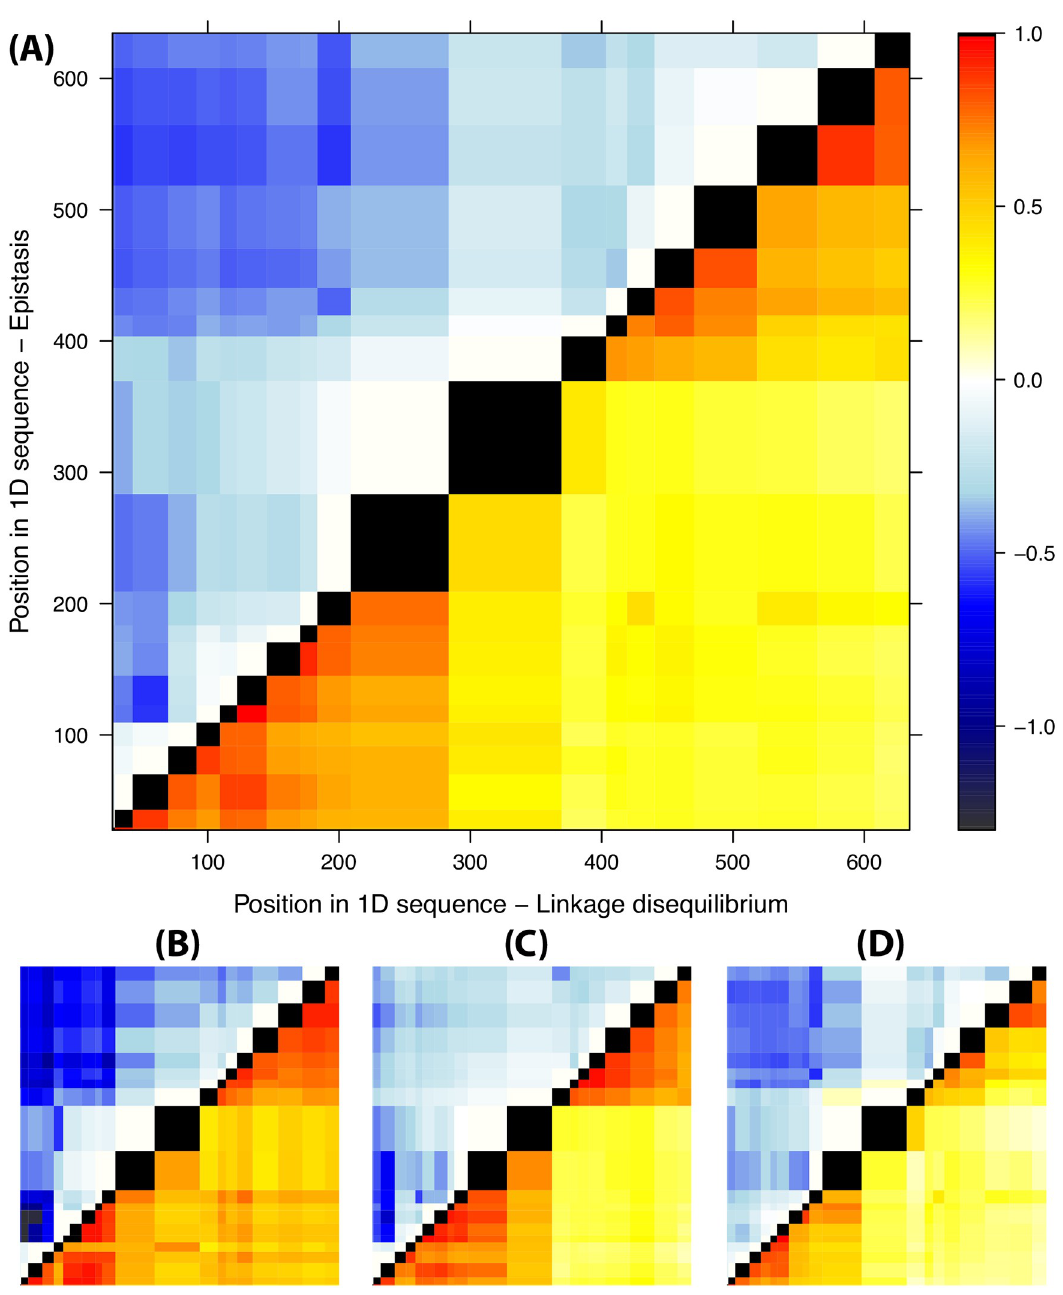
Fig 7. LD and epistasis across sequences from all animals (A), the two individuals sampled at 35 dpi (B,C) and the individual sampled at 400 dpi (D). Lower triangles: map of pairwise LD between variants in VP1, estimated as | D 0 | (stronger LD shown in red). Upper triangles: signatures of epistasis as detected by the suppression of recombination R (cid:0) R suppression shown in